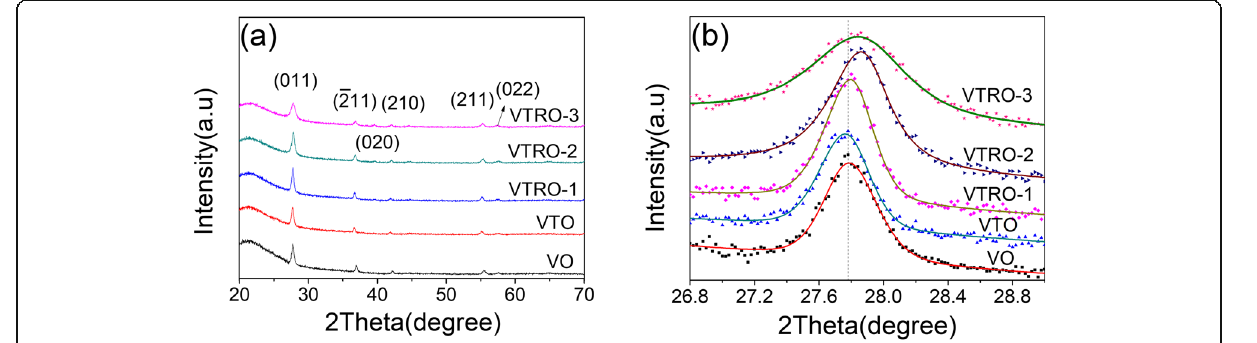
Fig. 2 a XRD patterns and b close-up views of (011) peaks of all the samples